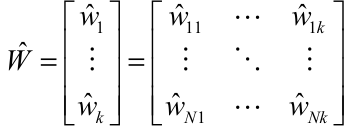
Figure 1. Algorithm to estimate ˆ